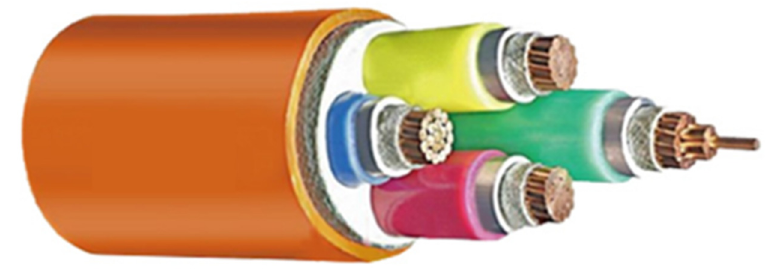
Figure 2. Torsion-resistant cable for wind power generation.